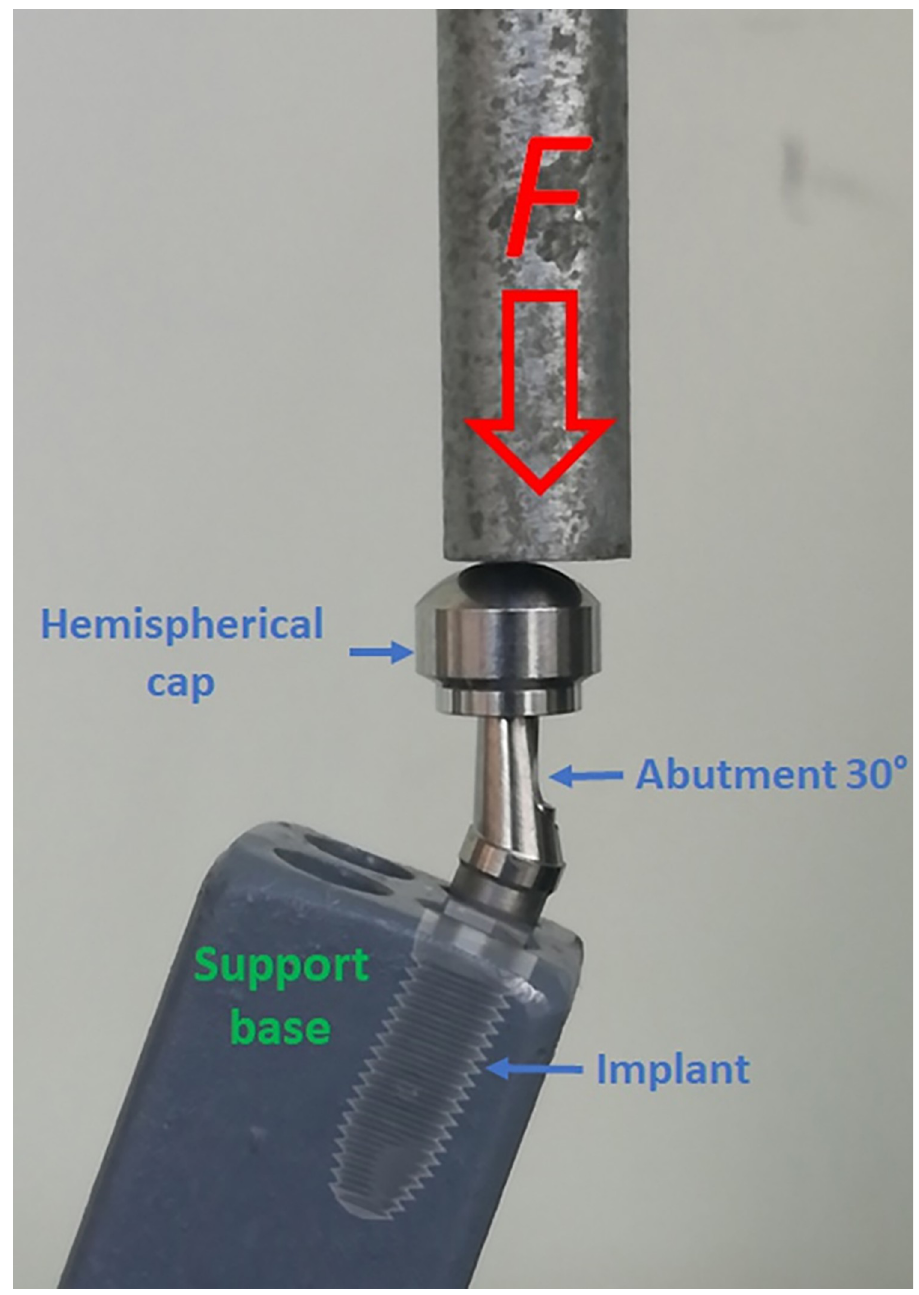
Fig 3. The components used in the test and the direction of load application on each